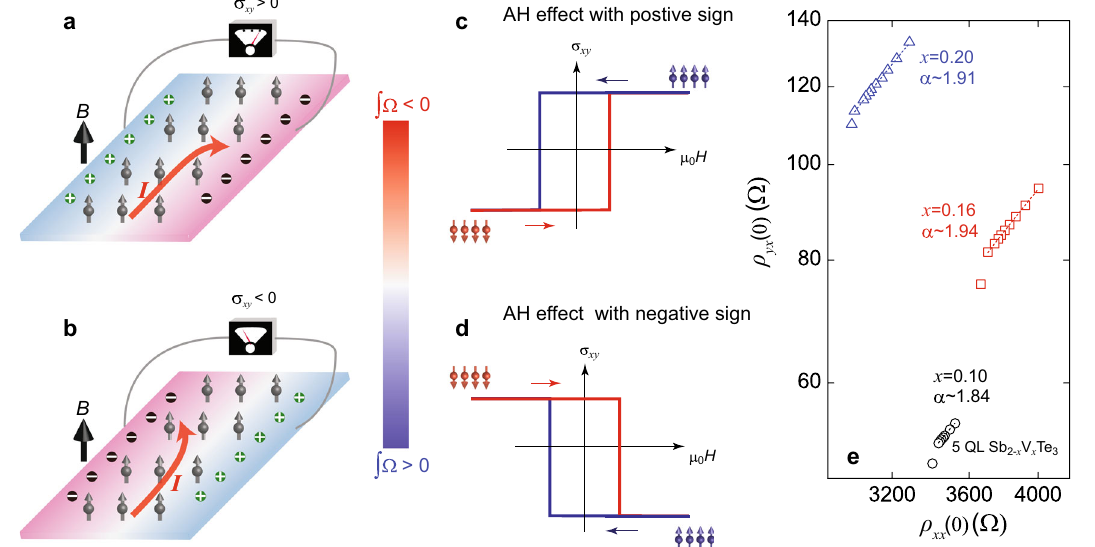
Fig. 1 Intrinsic anomalous Hall (AH) effect and Berry curvature Ω . a , b The intrinsic AH effect formed in the ferromagnetic materials with positive ( a ) and negative ( b ) Berry curvature Ω integration of the occupied Bloch bands when the internal magnetization points upward. I is the applied excitation current. ⊕ and Ɵ are hole and electron carriers, respectively. Blue and red colors indicate high and low electrical potentials. c , d The corresponding AH hysteresis in the ferromagnetic materials with positive ( c ) and negative ( d ) Berry curvature Ω integration of the occupied bands. The sign and value of the AH effect are determined by the sign and magnitude of Berry curvature Ω integration of occupied bands. The arrows indicate the magnetic fi eld sweep directions. The color bar is for a – d . e The plot of the AH resistance at zero magnetic fi eld ρ yx (0) as a function of the longitudinal resistance at zero magnetic fi eld ρ xx (0) on a log – log scale for three 5 QL Sb 2 − x V x Te 3 samples ( x = 0.10, 0.16, and 0.20). The dashed lines are the fi ts using ρ yx / ρ α xx , α = 1.84 ± 0.02, 1.94 ± 0.01, and 1.91 ± 0.02 for x = 0.10, 0.16, and 0.20 samples, respectively.